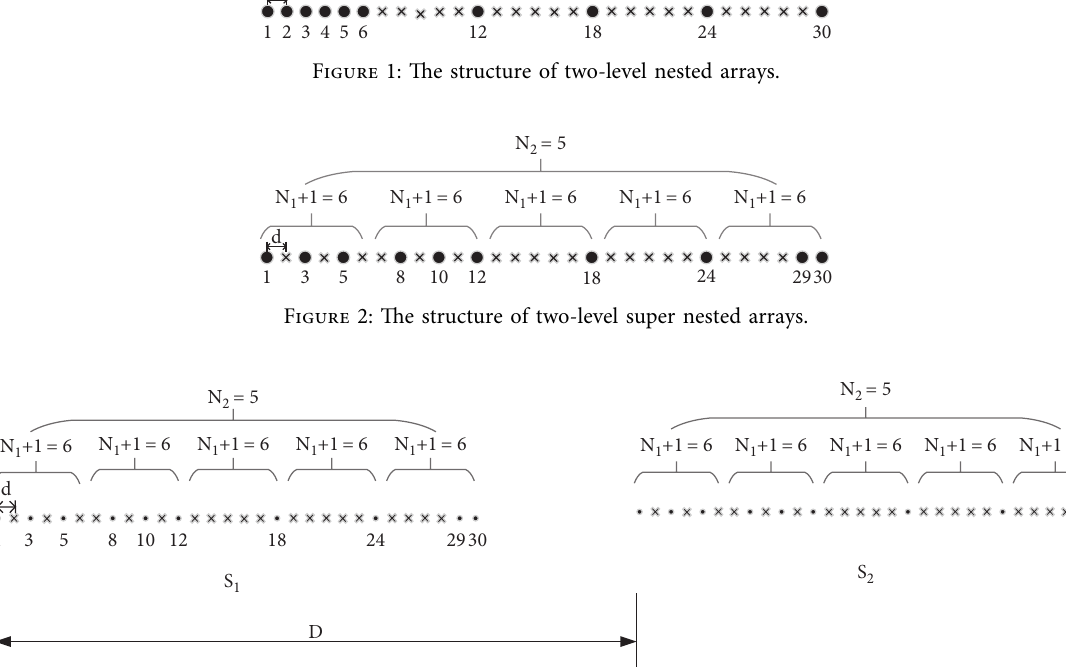
Figure 3: The structure of distributed two-level super nested arrays.